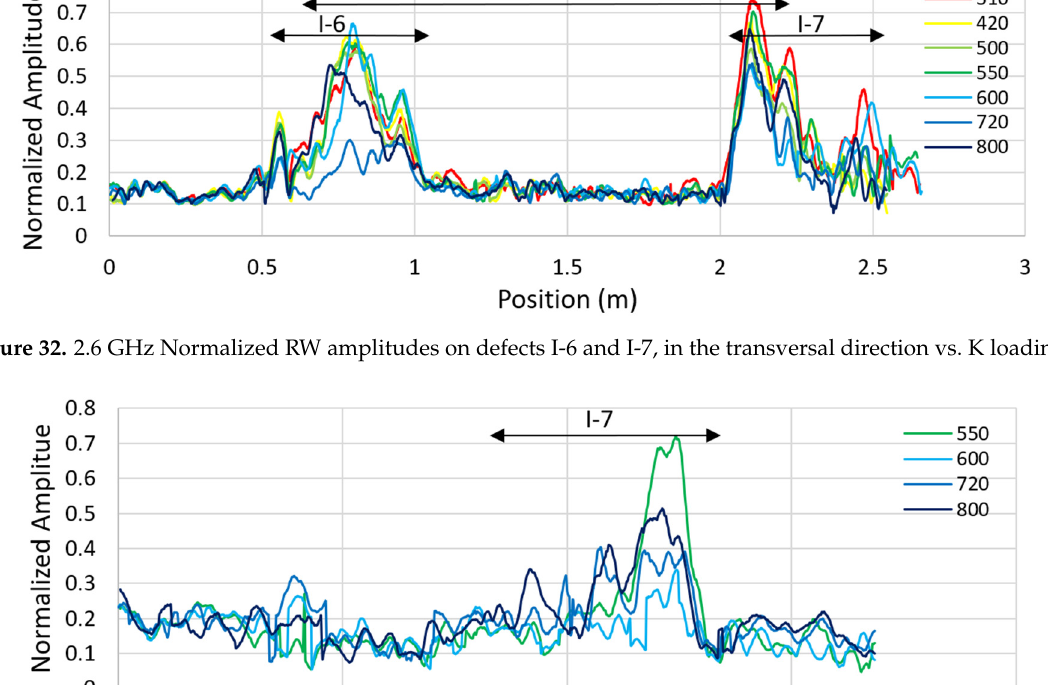
Figure 31. 2.6 GHz Normalized RW amplitudes on defect I-6, in the longitudinal direction vs. K loadings.